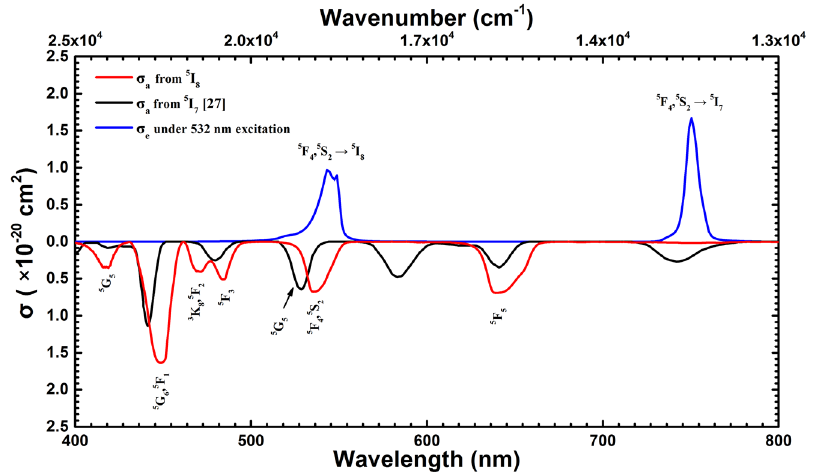
Figure 2: Spectra of GSA (red), ESA (black) and fluorescence emission (blue) cross sections along with assignments of Ho 3 + -doped ZBLAN fi ber.